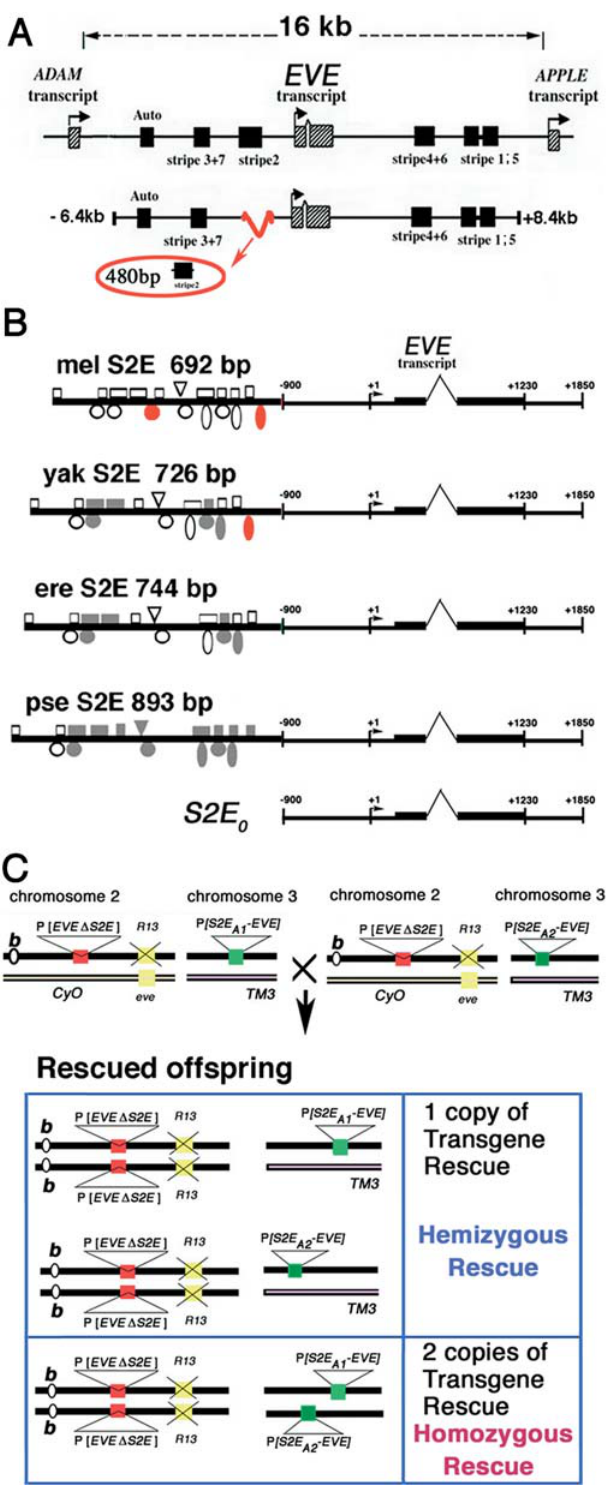
Figure 2. Genetic Constructs and Rescue Scheme (A) Summary map of the eve locus and eve S2E deletion transgene (EVE D S2E). Adam and Apple are adjacent open reading frames [40]. The late element (Auto) and early stripe enhancers are shown. (B) S2E-EVE transgenes used to rescue eve function. The rescue EVE locus used is the D. melanogaster eve flanked by 0.9 kb of 5 9 and approximately 0.6 kb of 3 9 of endogenous sequence. The S2E o -EVE does not have any S2E sequences and is a negative control. The known trans -factor-binding sites in the S2E from D. melanogaster : five PLoS Biology |